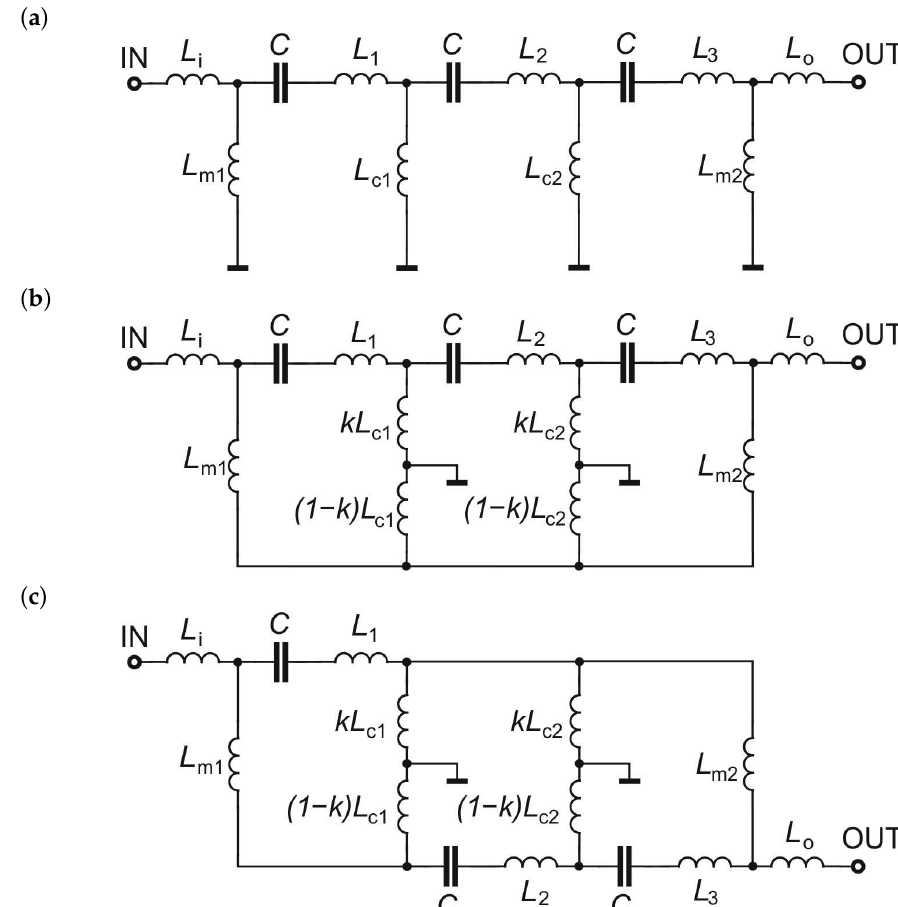
Figure 1. Transforming of the lumped element bandpass filter: ( a ) the initial filter, ( b ) the filter with split coupling inductances, and ( c ) the final TTMC filter with swapped branches.